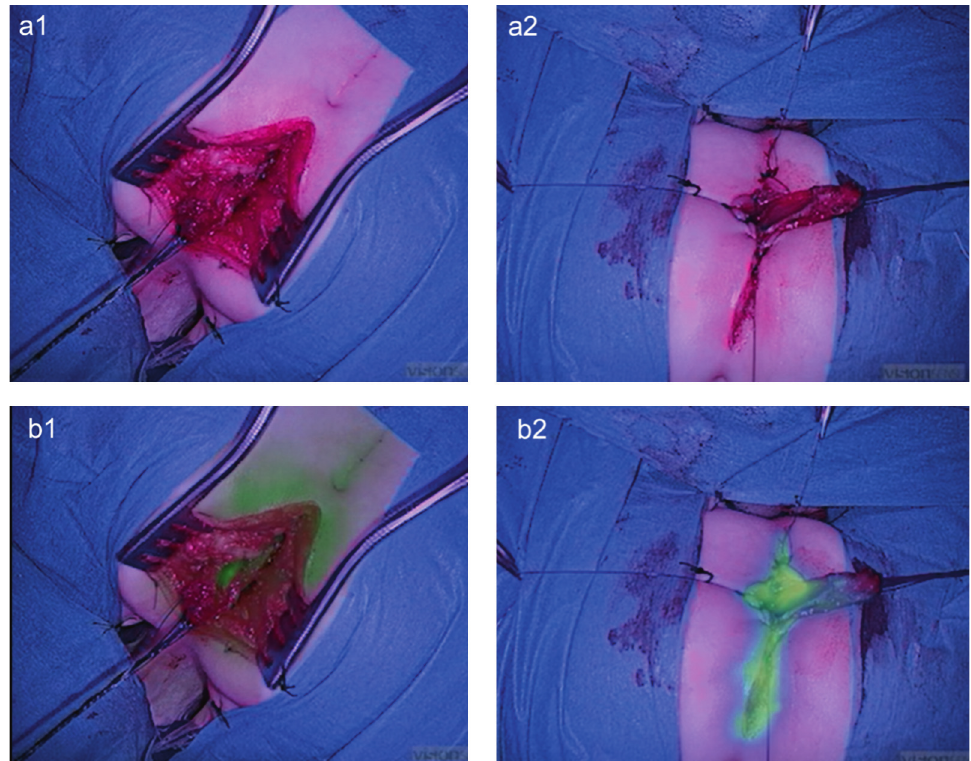
Fig. 2 Intraoperative indocyanine green (ICG) fl uorescence. ( A1 , A2 ) Visible light images. ( B1 , B2 ) Near-infrared (NIR) images. ( B1 ) Assessment of intestinal perfusion during the pull-through lengthening maneuvers was a valuable fi rst step after disconnecting the rectourethral fi stula. ( B2 ) A second dose of ICG was injected to visualize the vascular perfusion of the intestine and perineal wound edges before the anoplasty.